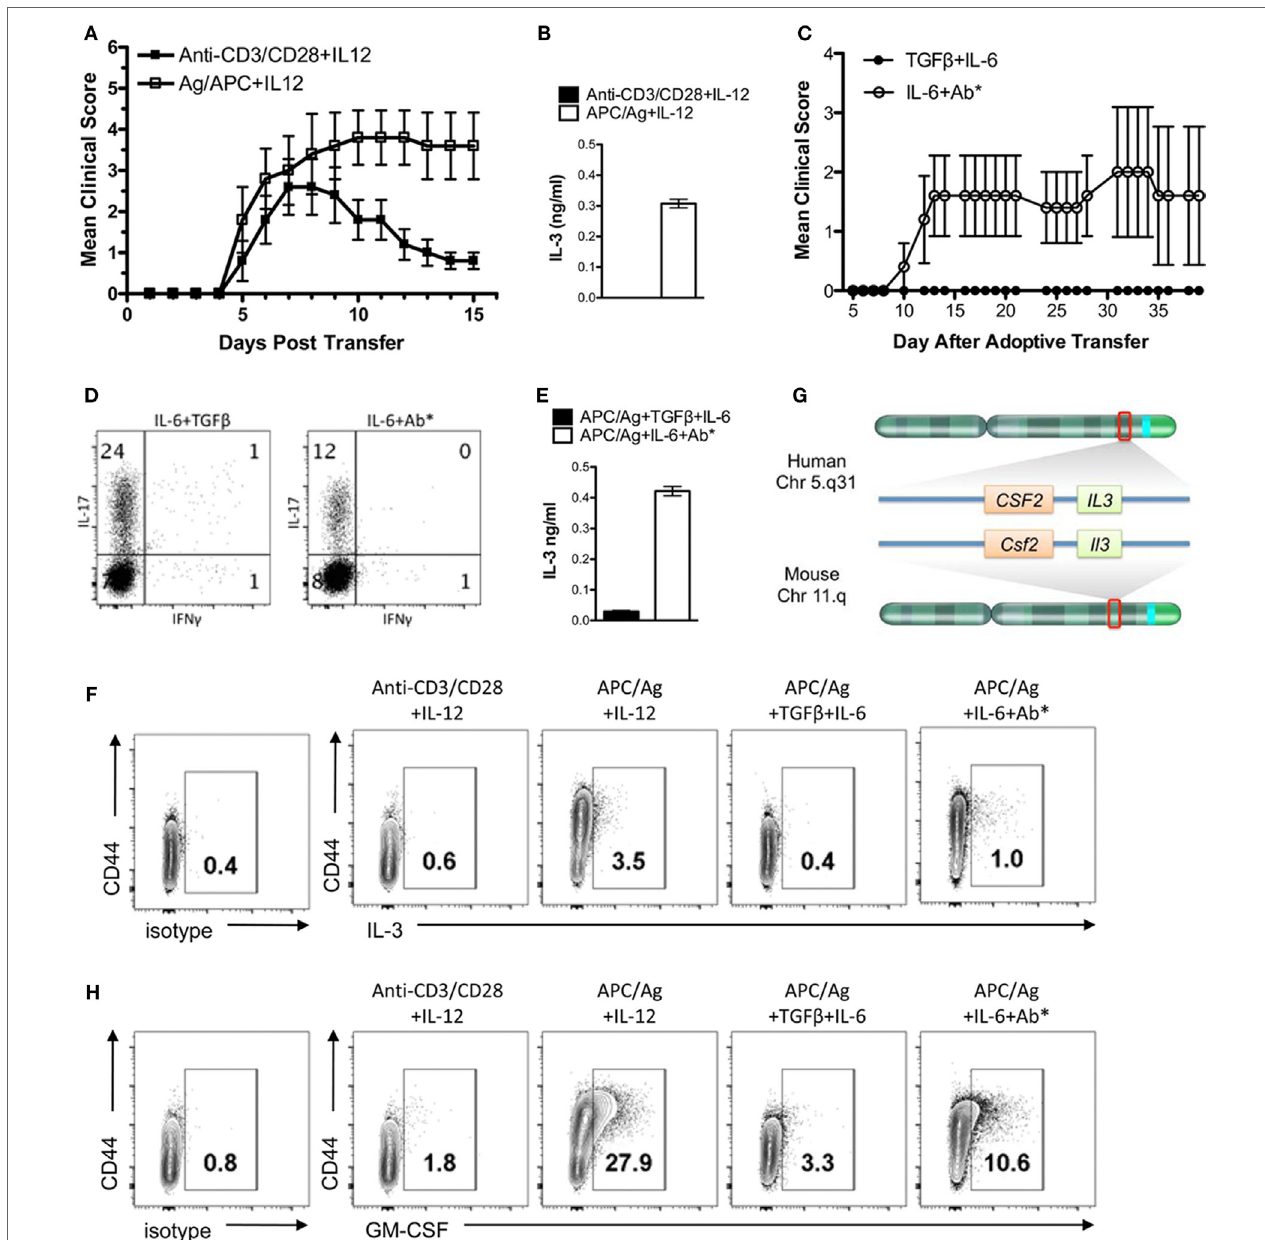
fiGUre 1 | IL-3 is highly expressed in encephalitogenic Th1 and Th17 cells. Splenocytes from naïve MBP-specific T cell receptor Tg mice were differentiated into Th1 cells with plate-bound anti-CD3/28 Ab plus IL-12 or antigen-presenting cell (APC)/Ag plus IL-12 . Th17 cells were differentiated with APC/Ag plus IL-6 + TGF- β or APC/Ag plus IL-6 + anti-IL4/IL12/IFN γ . (a,c) Cells were collected and transferred into B10.PL mice (5 × 10 6 cells/mouse). Experimental autoimmune encephalomyelitis clinical scores were monitored daily. Data are representative of three independent experiments (mean ± SEM). ** p < 0.01, Mann–Whitney U test. (B,e) Supernatants were analyzed by ELISA for IL-3. (D) Flow cytometric analysis of IL-17 and IFN γ in Th17 cells. (f) IL-3 and (h) GM-CSF were stained intracellularly and analyzed by flow cytometry (gated on CD4 + cells). (G) Illustration of IL-3 and GM-CSF loci in mouse and human